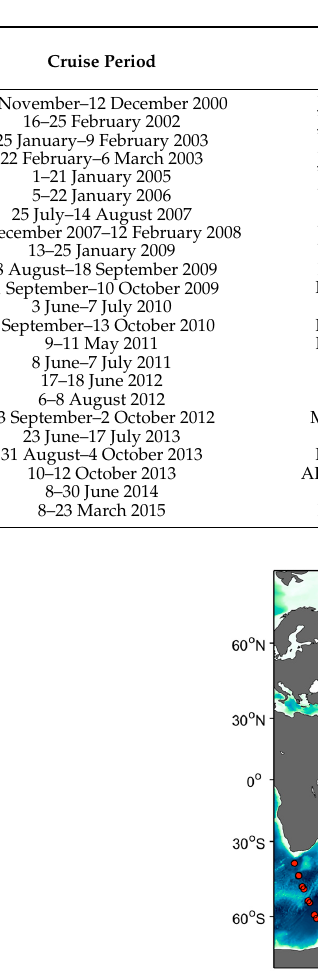
Table 1. Cruises information and number of data obtained during each cruises.